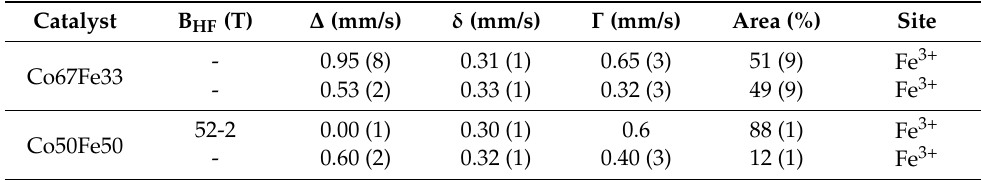
Figure 6. 57 Fe Mössbauer spectra of the mixed Co-Fe spinels ( a ) Co67Fe33 and ( b ) Co50Fe50. Table 6. Room temperature 57 Fe Mössbauer parameters of the Co-Fe oxide